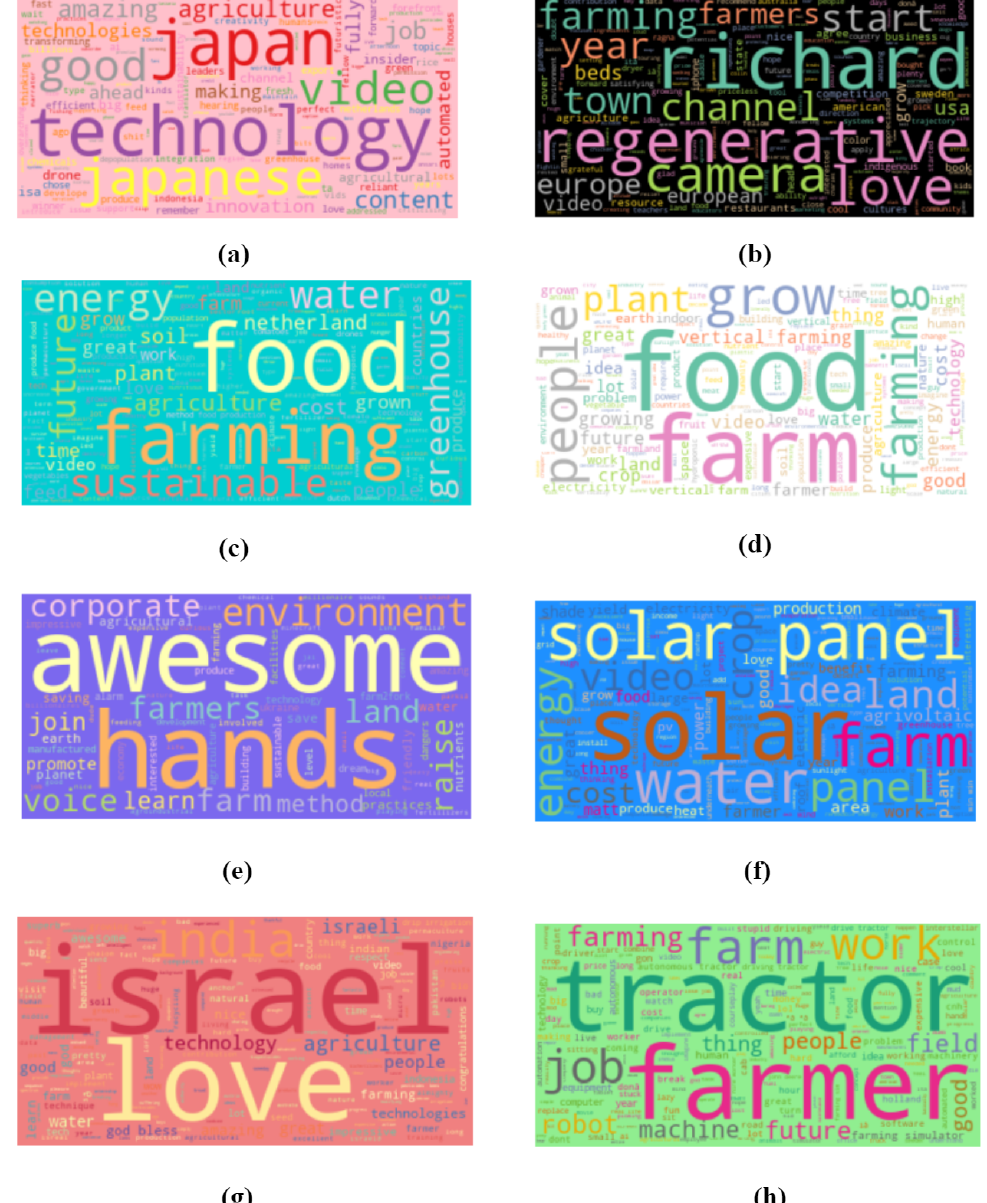
Figure 8. Word clouds for videos serial no. 1–8 corresponding ( a – h )